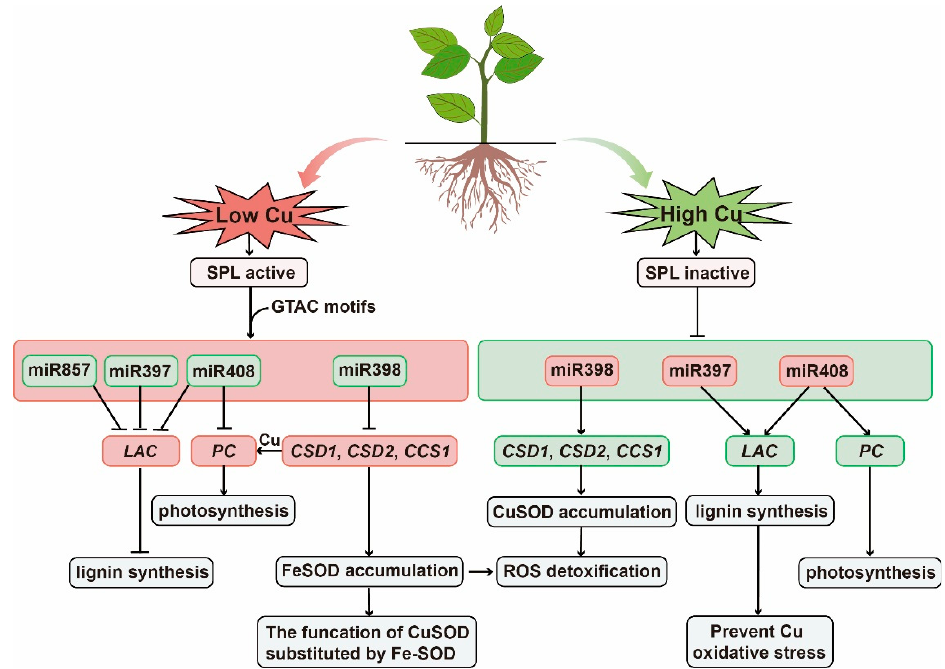
Figure 2. Schematic representation of the mode of action of miRNAs in response to Cu stress. Green boxes indicate relevant miRNAs and pathways involved in low Cu stress. SPL7 transcription factors are active and regulate miR397, miR398, miR408, and miR857, which regulate genes encoding Cu-containing proteins, including Cu/Zn superoxide dismutase ( CSD ), CCS1 , laccase ( LAC ), and phycocyanin ( PLC ), thereby conserving Cu as essential Cu protein (such as plastocyanin). Red boxes indicate that under high Cu stress, SPL7 is inactivated, miR398 is down-regulated, and the expression of target genes CSD1 , CSD2 , and CCS1 is up-regulated, mitigating the threat of ROS from increased Cu content and increased Cu protein accumulation.